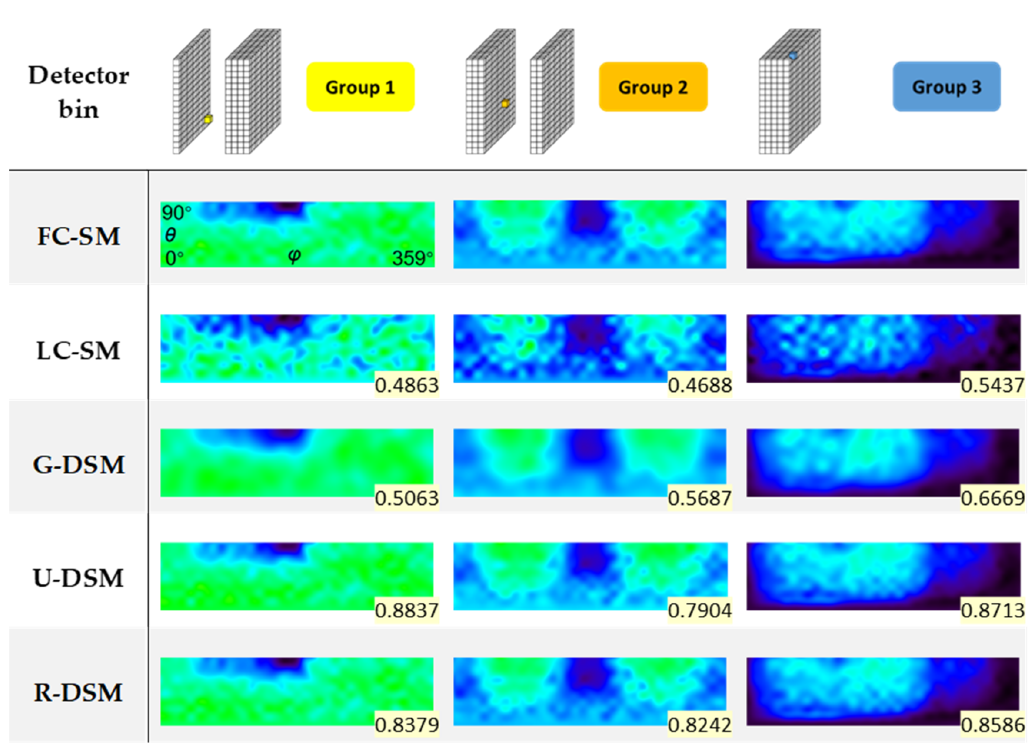
Figure 11. Representative DRF images of FC-SM, LC-SM, G-DSM, U-DSM, and R-DSM for 137 Cs source. SSIM value between each DRF image and FC-SM case is given in the bottom-right corner. For both the 99m Tc source and 137 Cs source, the DRFs of LC-SMs (third row in Figures 10 and 11) are evidently different from those of FC-SMs (second row) due to increased noise. Compared with LC-SMs, the DRFs of G-DSMs (fourth row) are much smoother after Gaussian filtering but with an unavoidable loss of details. DRFs of U-DSMs (fifth row) and those of R-DSMs (sixth row) are visually more similar to those of FC-SMs after U-net-based denoising and Res-U-net-based denoising, respectively. R-DSMs yield slightly better recovery of details. The mean and standard deviation (SD) of SSIM calculated for 10 testing LC-SMs and FC-SM, as well as those between DSMs and FC-SM for 99m Tc and 137 Cs sources, are listed in Table 2 and Table 3, respectively. For both 99m Tc and 137 Cs sources, the three denoising methods can improve SSIM, among which U-DSMs and R-DSMs reach higher SSIM val- ues, while G-DSMs have the worst performance. Table 2. SSIM (mean ± SD) with FC-SM of LC-SMs, G-DSMs, U-DSMs, and R-DSMs for 99m Tc. SM